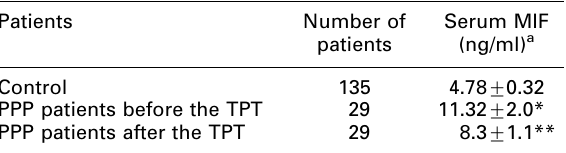
Table 1. Serum MIF contents of PPP patients and MIF contents fell after the TPT